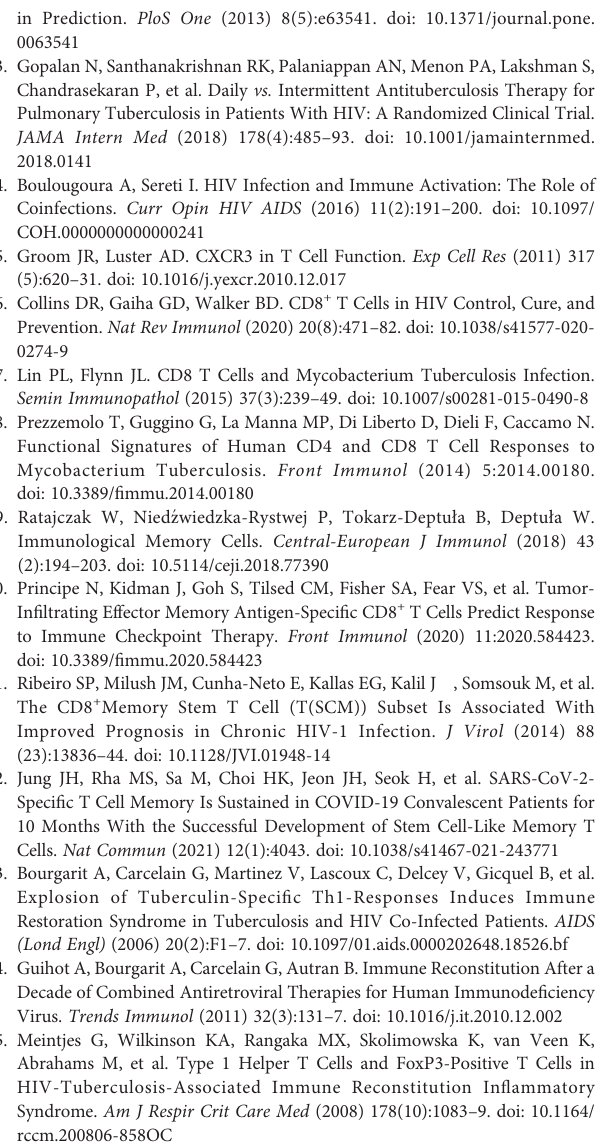
Supplementary Figure 1 | Expression of CXCR3 + in memory CD8 + T cells from patients that initiated ART with more or less than 4 weeks difference from ATT initiation. We employed a hierarchical cluster analysis of z-score normalized values ofCXCR3 + memoryCD8 + T lymphocytesatBaseline (A) andattimepoint 1 (B) .The right panel depicts Spearman correlation coef fi cient values between time from ATT to ARTinitiation vs. the frequencyof indicated parameters. (C) Violin plots represent the frequencies of each CXCR3 + memory CD8 + T cell in our study groups. Data were analyzed using the Mann-Whitney test or Wilcoxon matched-pairs test for paired analyses within each study group (**p < 0.01, ****p < 0.0001). Data were analyzed using the Mann-Whitney test or Wilcoxon matched-pairs test for paired analyses within each study group (* p < 0.05, **p < 0.01, ***p < 0.001, ****p < 0.0001). Supplementary Table 1 | Characteristics of the study participants. Supplementary Table 2 | Antibody Panel used to assess CD8 + T lymphocyte memory